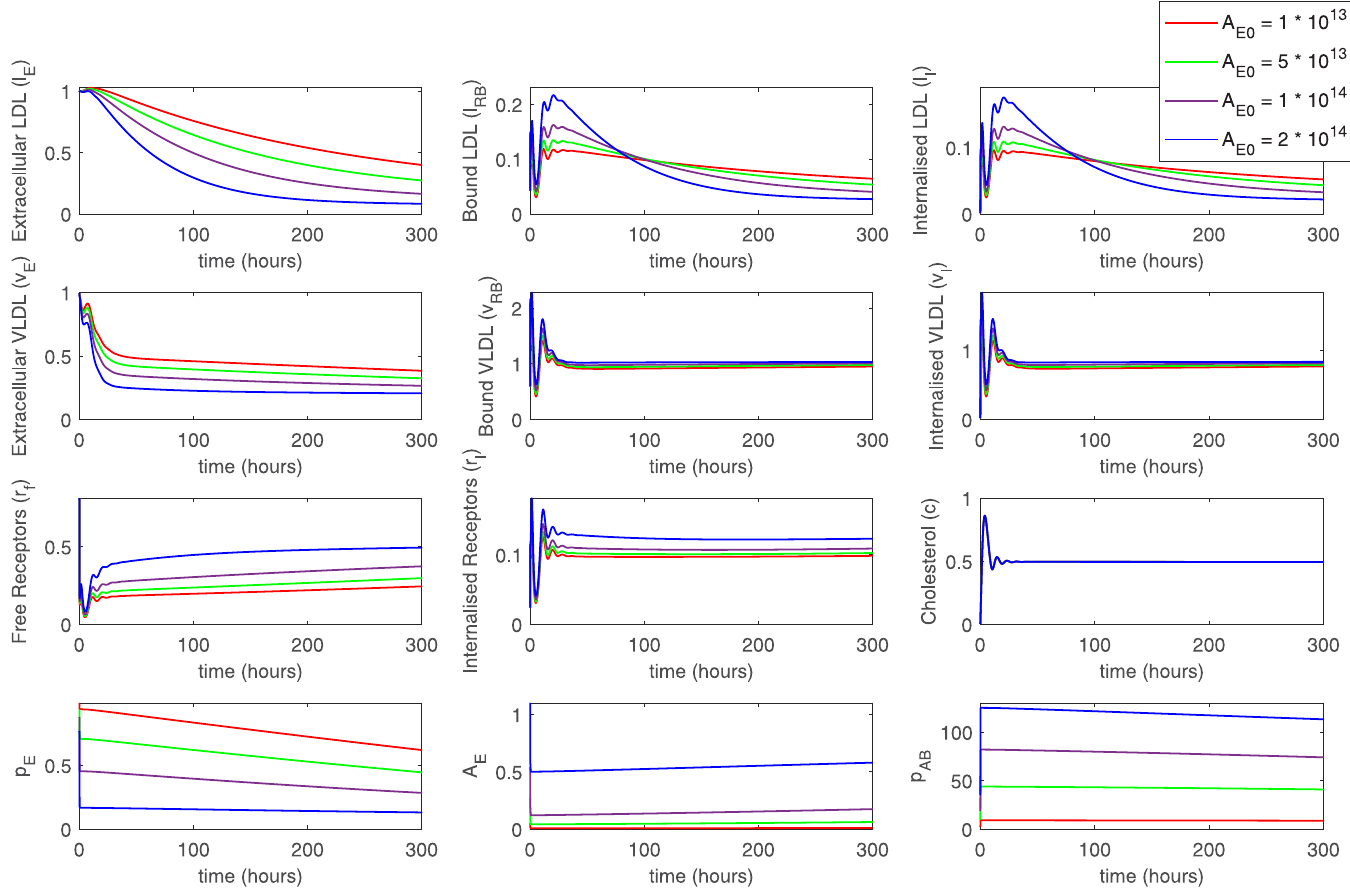
Fig 6. A simulation showing the effect of anti-PCSK9 antibodies therapy. Here antibodies were applied at the zero time point at different concentrations. Initial concentration of PCSK9 is 10 14 molec./mL. The binding of PCSK9 with antibodies prevents its binding with LDLR and leads to the decrease in LDL/VLDL levels.